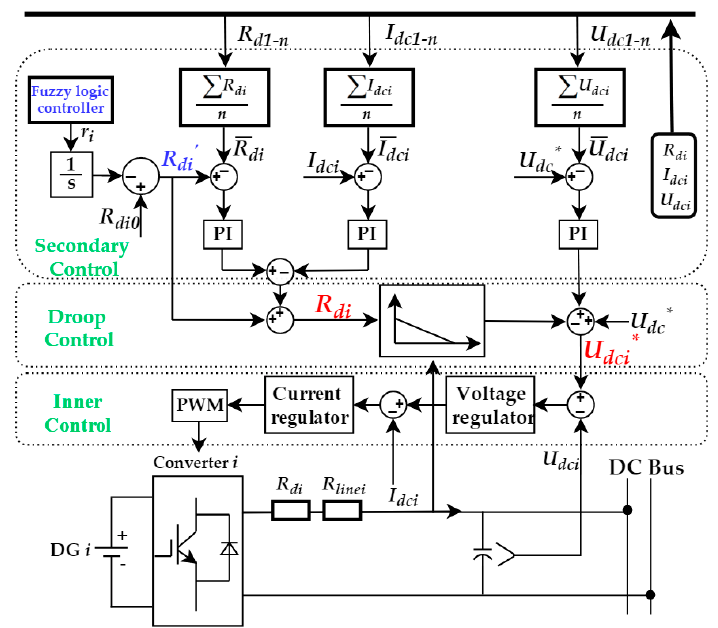
Figure 10. The structural diagram of the improved hierarchical control algorithm.